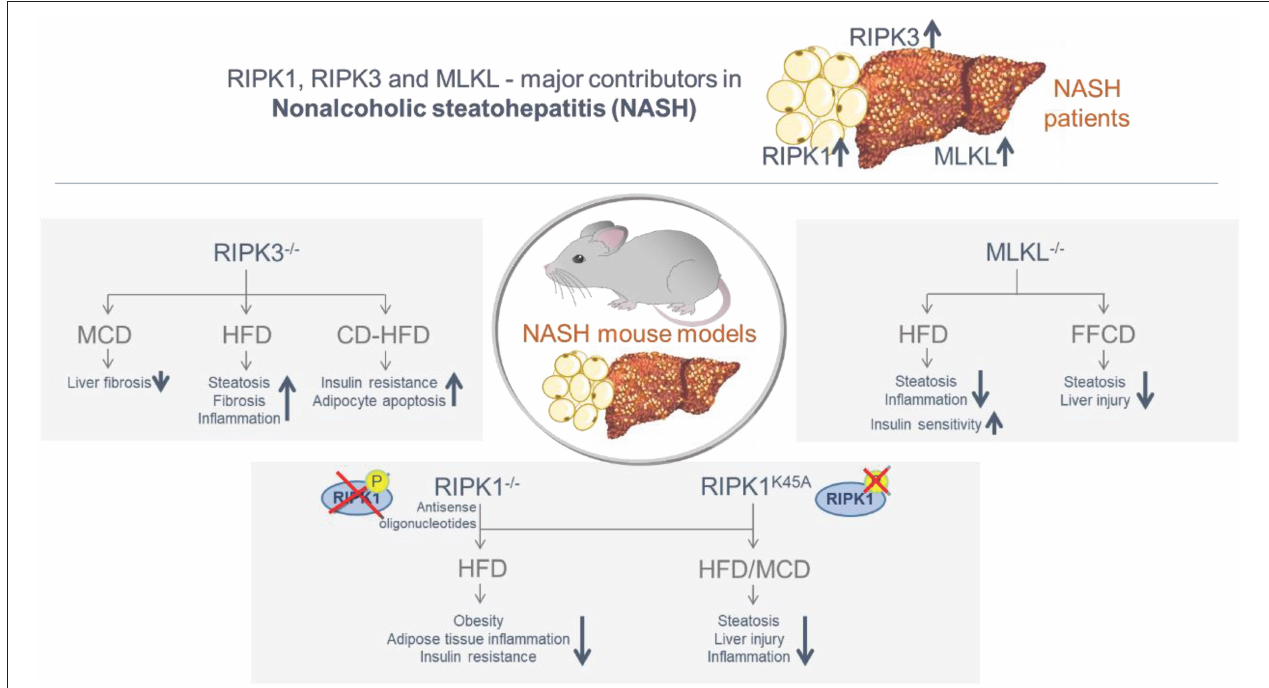
FIGURE 3 | Summary of the involvement of the necroptosis-associated proteins RIPK1, RIPK3 and MLKL in obese/NASH patients and in murine NASH models. The necroptosis-associated proteins RIPK1, RIPK3, and MLKL are overexpressed in the liver and/or adipose tissue of NASH patients. Murine NASH studies with distinct knock-in and knock-out mouse models confirmed an essential function of RIPK1, RIPK3, and MLKL in the transition from NAFLD to NASH and NASH-fibrosis, including both protective and inducing mechanisms. While RIPK3 deletion led to a decrease in fibrosis in the MCD model, NASH progression was observed in the HFD and CD-HFD models. Deletion of RIPK1 and MLKL was predominantly protective in the MCD and HFD